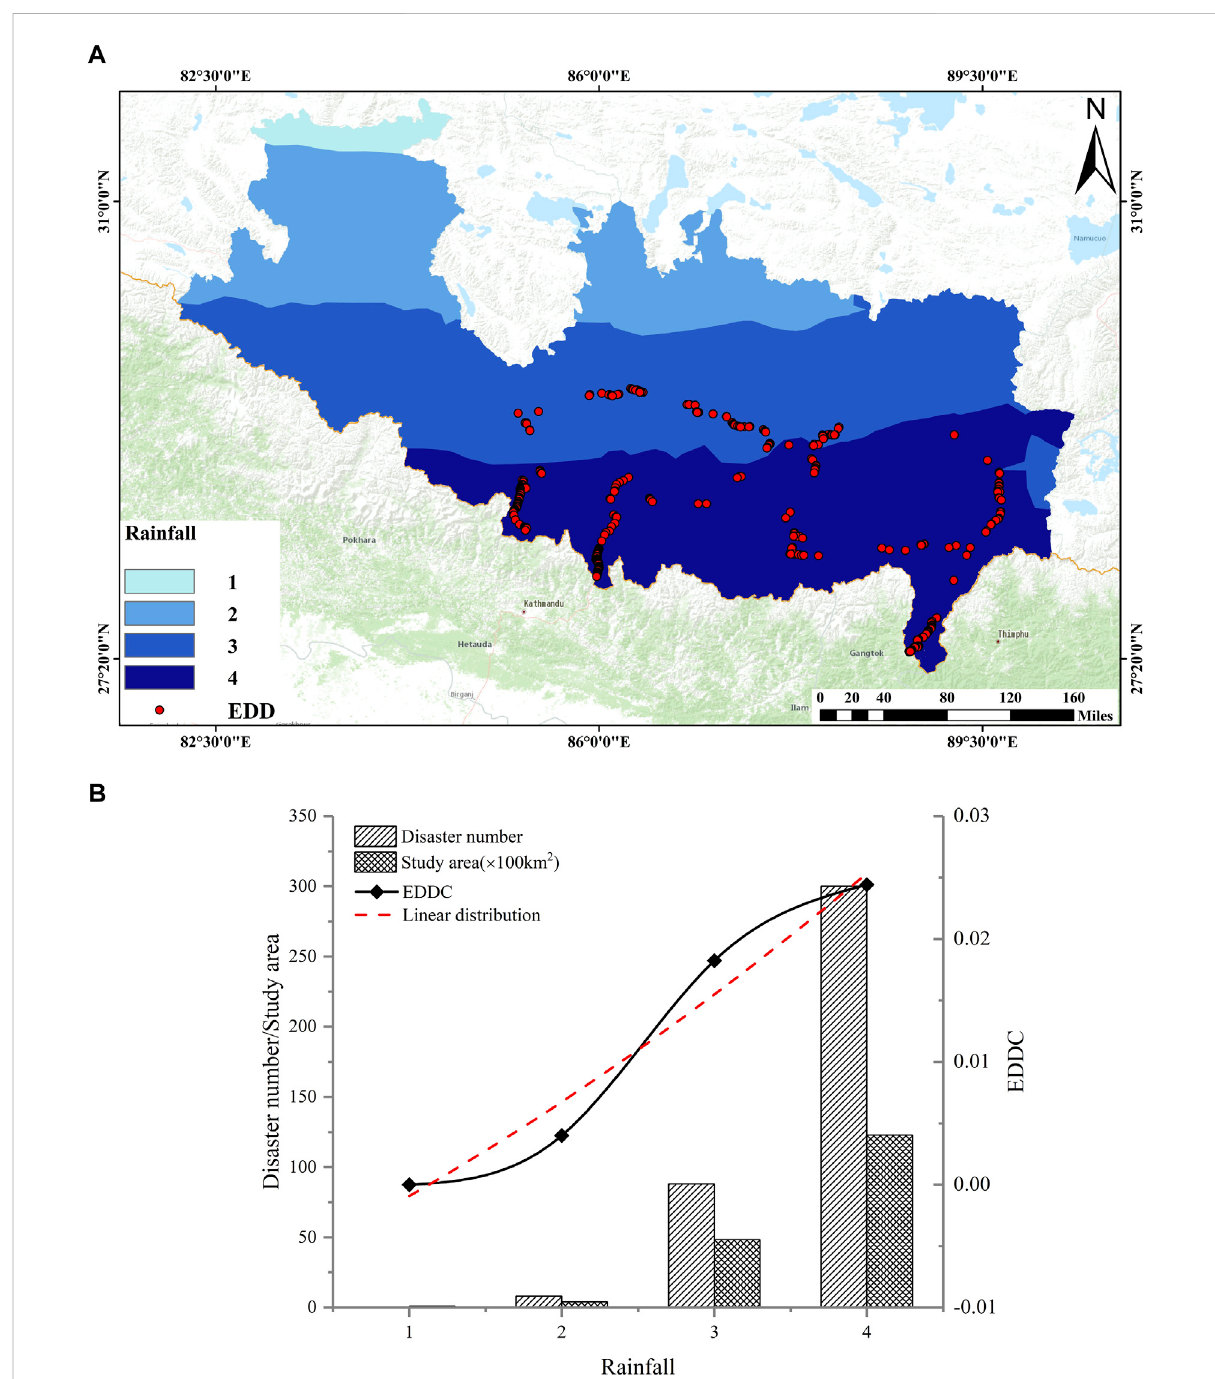
FIGURE 13 (A) Rainfall map of the study area; (B) Relationship between engineering disturbance disaster distribution and